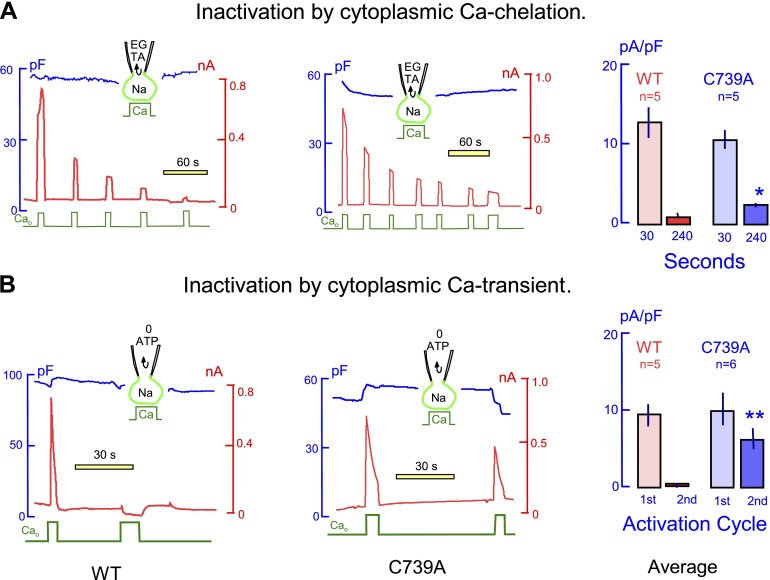
Effect of palmitoylation on NCX1 inactivation by Ca depletion and excess. Stably transfected FT-293 cells expressing WT and C739A NCX1 were voltage clamped in the whole-cell mode. Current traces are shown in red, capacitance traces in blue, and changes in extracellular Ca indicated in green. Outward NCX1 currents were activated by stepping extracellular Ca from 0 to 4 mM in cells expressing WT (left) and C739A exchangers (center). A) Effect of removal of intracellular Ca with EGTA. NCX1 inactivation is significantly slower in C739A NCX1 compared with WT: 240 s after application of EGTA a significantly greater current remains in cells expressing C739A NCX1 (right). *P < 0.05 vs. WT. B) Effect of PIP2 depletion by a large Ca transient in the absence of intracellular ATP. In this protocol, the magnitude of the initial NCX1 current remains stable for periods of many minutes although the cytoplasmic ATP concentration is nominally zero. The initial activation cycle results in complete NCX1 inactivation in WT but not C739A-expressing cells (right). **P < 0.01 vs. WT.